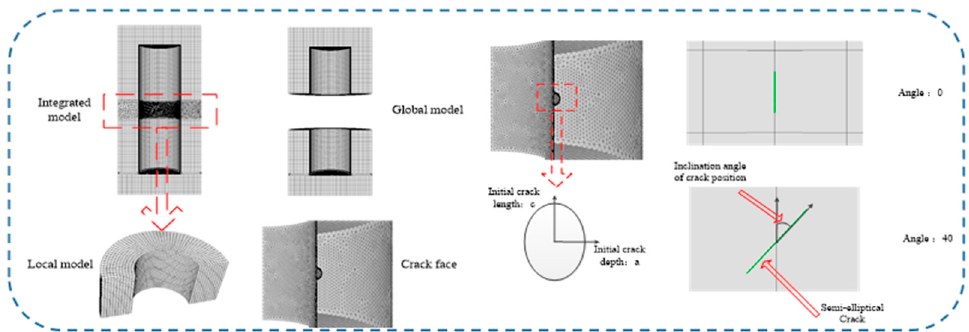
Figure 12. Global finite element model and sub-model with a surface crack.